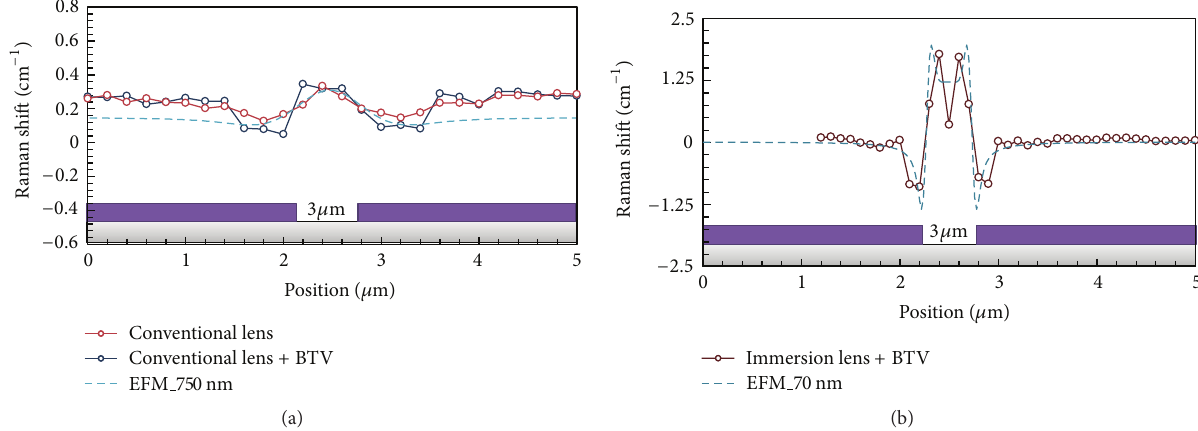
Figure 9: One-dimensional profiles of Raman wavenumber shifts for the Si substrate with a patterned SiN film (0.3 𝜇 m space width) by conventional and super-resolution Raman spectroscopy with (a) conventional and (b) immersion lenses compared with the EFM